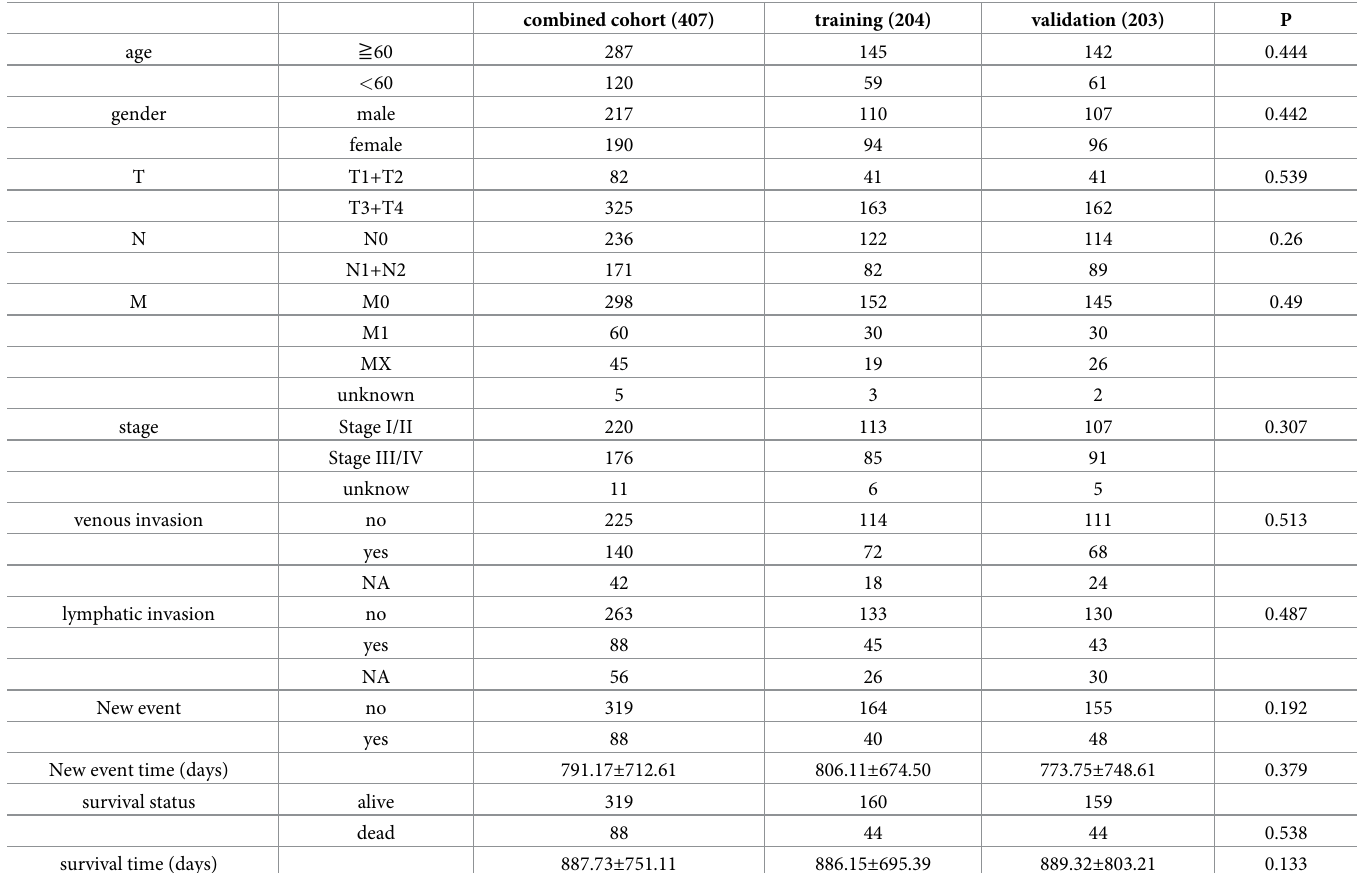
Table 1. The main clinical and pathological characteristics of the 407 CC